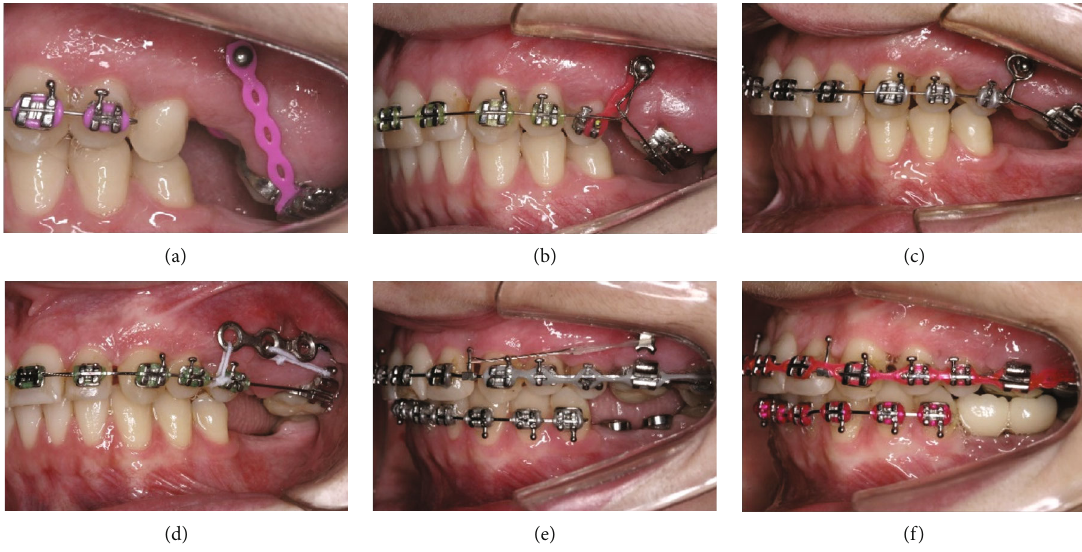
Figure 5: Progress sequence of the intrusion of maxillary left molars from fi rst to fi nishing stages.